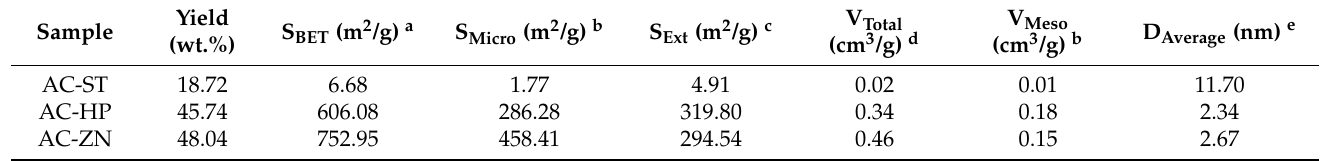
Table 2. Mass yields of the obtained carbon materials and their surface areas and pore